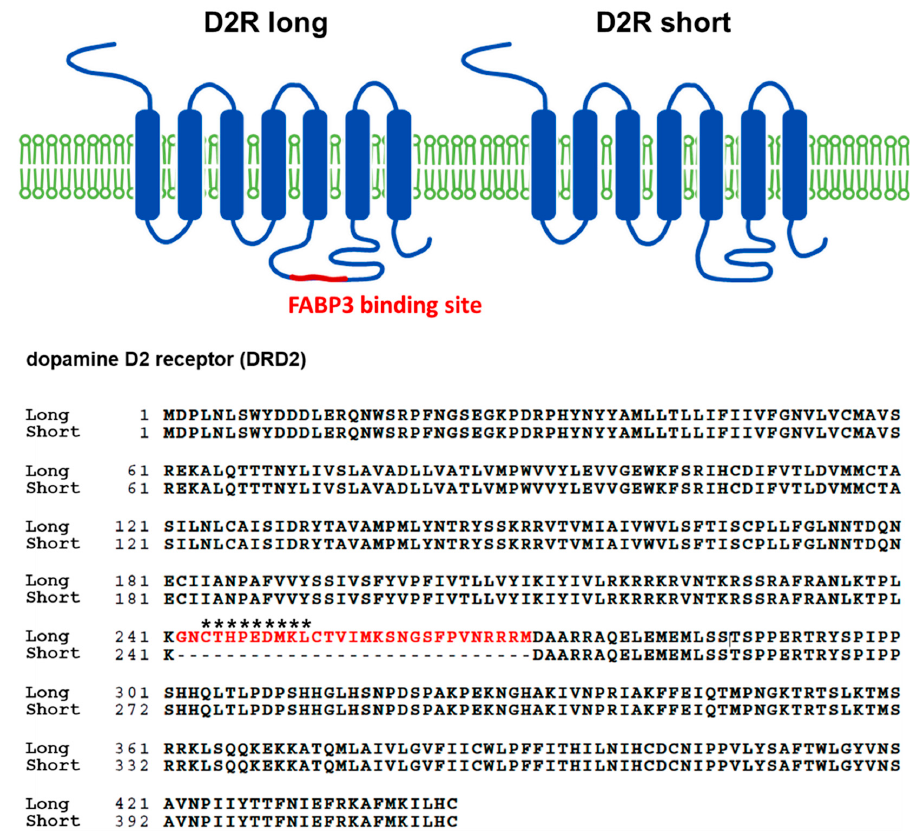
Figure 1. The primary sequence of mouse dopamine D2 receptor long ( left ) and short ( right ) isoforms. Amino acid sequences in red letters are specifically expressed in the long type. The dopamine D2 receptor short isoform ( right ) lacks these 29 amino acid sequences, which interact with fatty acid-binding protein 3 (FABP3). Asterisks indicate the antigen used to produce D 2L specific antibody used in this study.